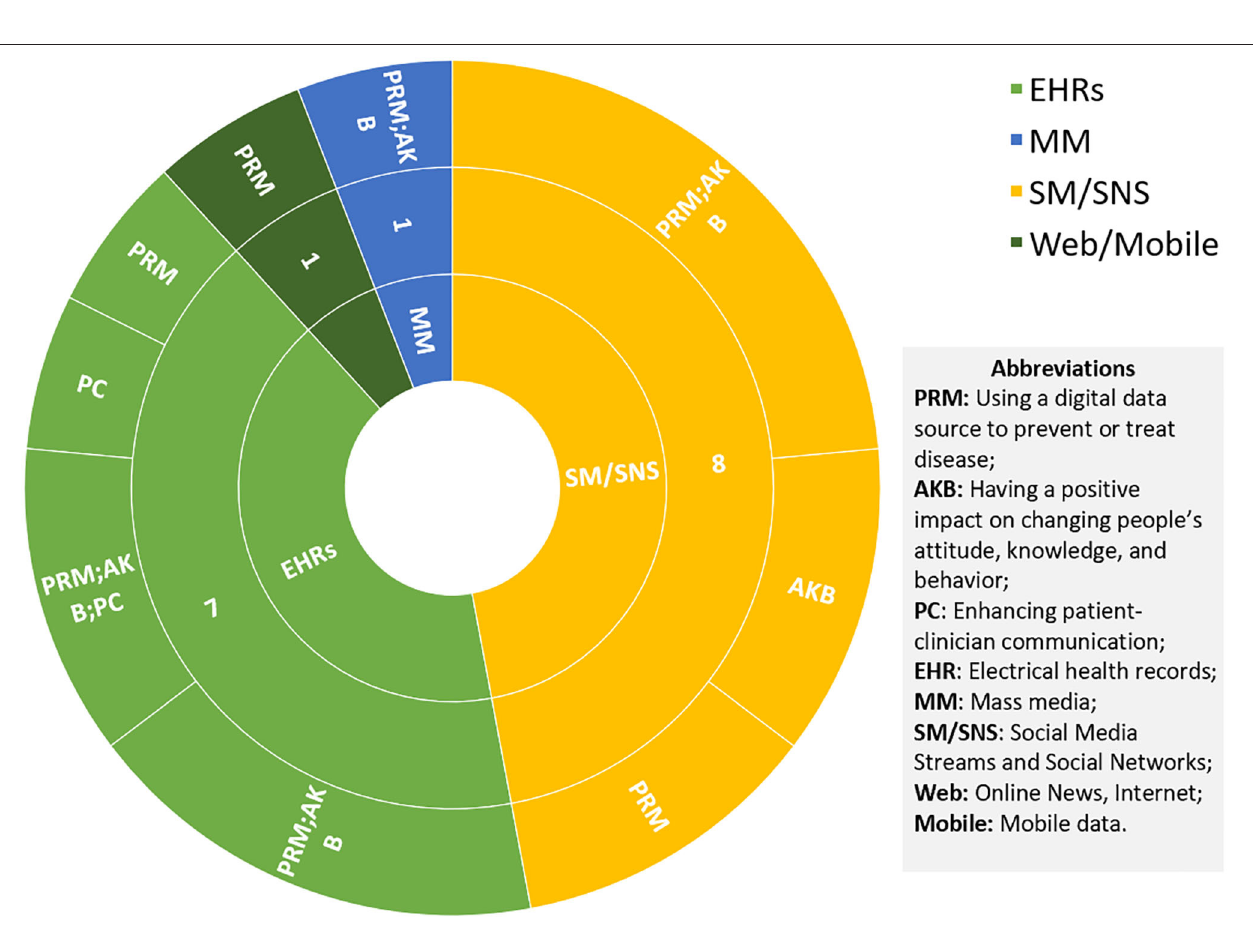
FIGURE 5 | Sunburst chart of each digital source and its impact on